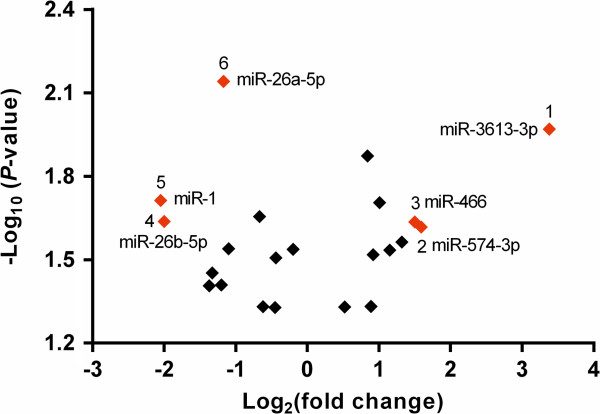
Volcano plot of 22 miRNAs significantly dysregulated in LAA tissues. The volcano plot shows the distribution of these miRNAs according to their P-value versus fold change. Those with the highest fold change in their expression (|Log2(fold change)| ≥ 1.5) have been labeled in red. Although the fold change of miR-26a-5p (|log2(fold change)| = 1.17) does not meet the criteria, its P-value is <0.01 (i.e., –Log10(P-value) > 2), and therefore is also labeled red.